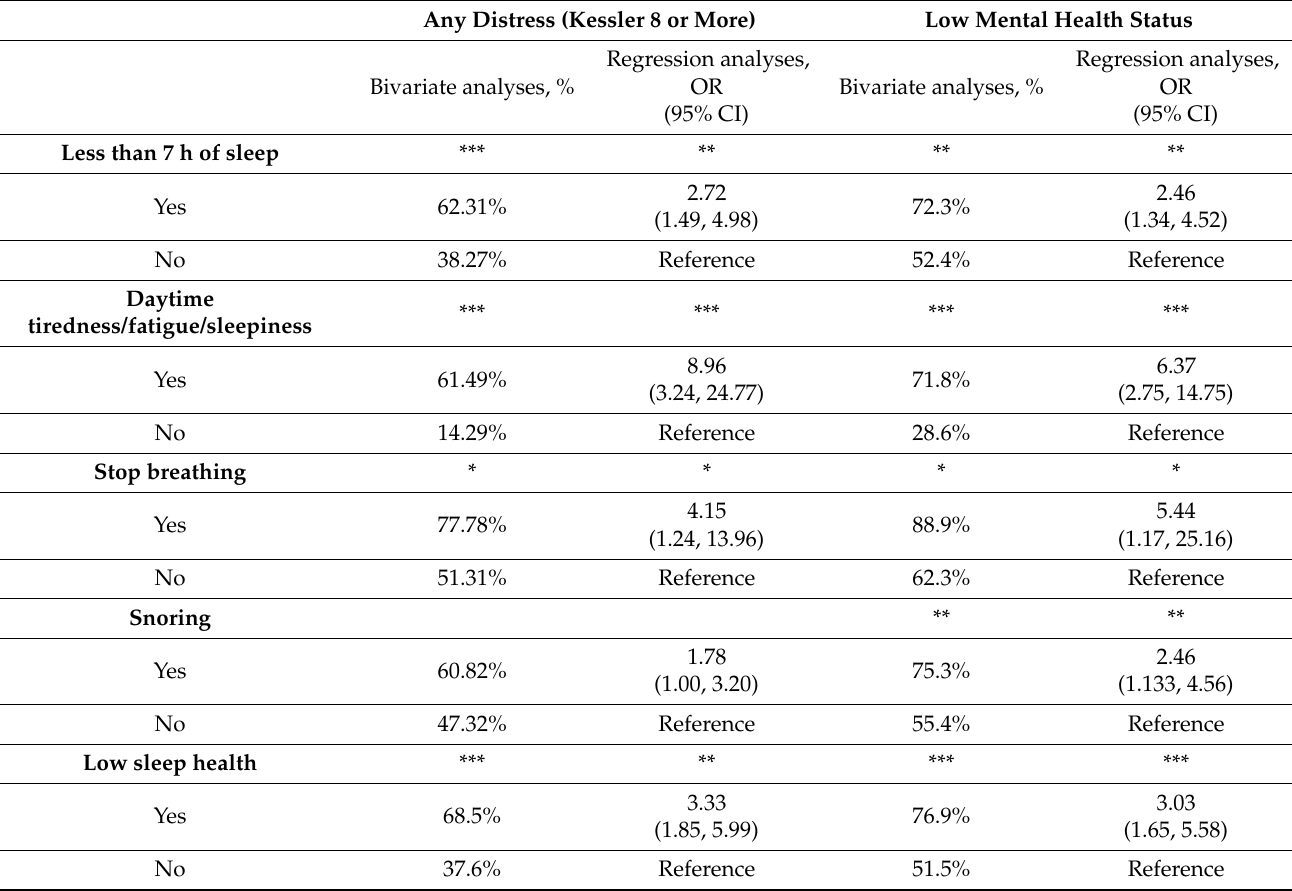
Table 3. Bivariate and adjusted associations between sleep health characteristics and mental health